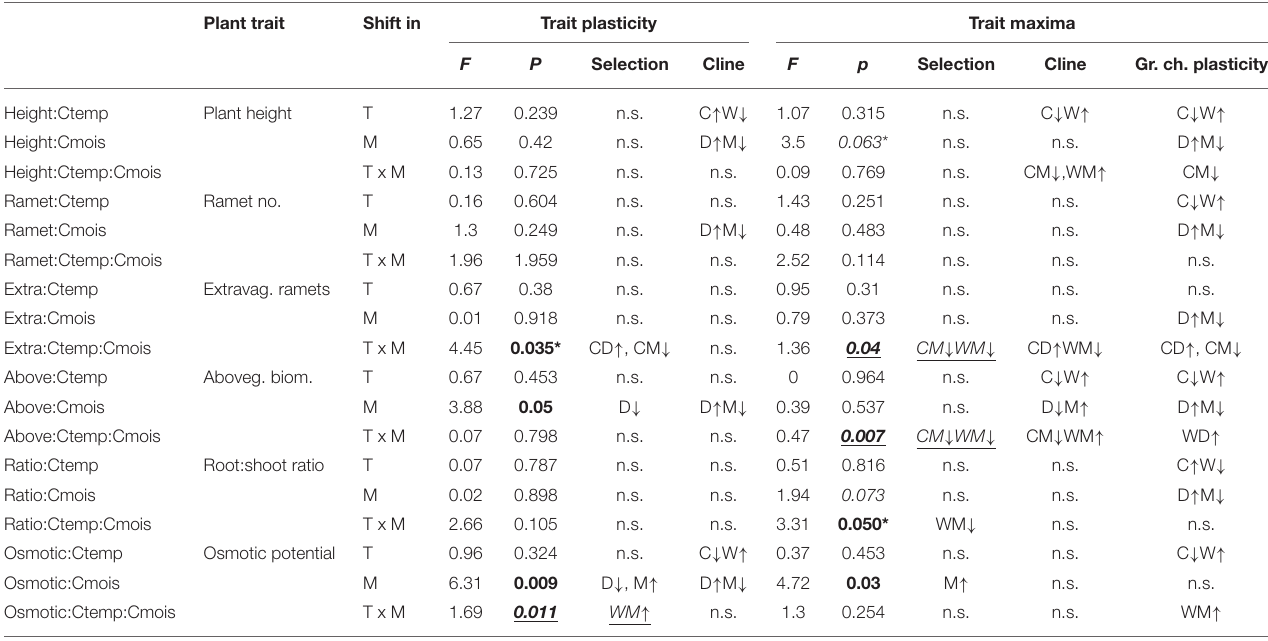
TABLE 1 | The effects of trait plasticity and trait maxima (previously measured in growth chambers) in interaction with shift in temperature (T) and moisture (M) on ramet survival in the field experiment. Plant trait Shift in Trait plasticity Trait maxima F P Selection Cline F p Selection Cline Gr. ch.